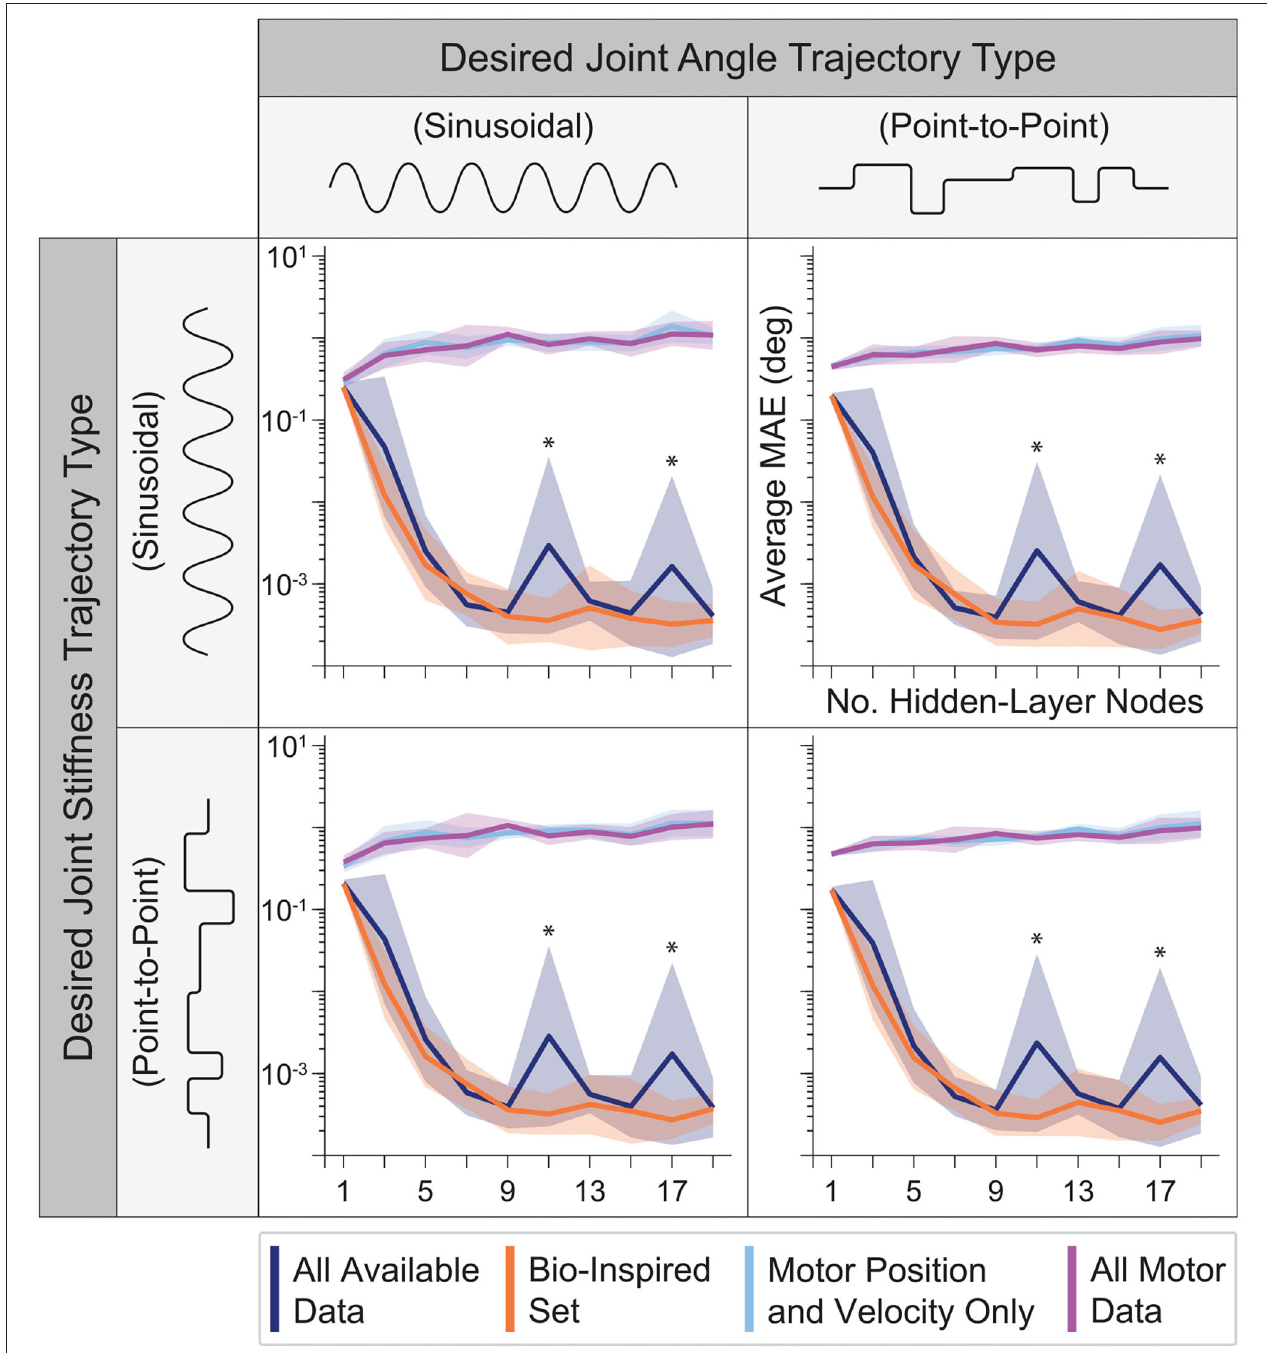
FIGURE 8 | The average performance (MAE) and relative standard deviation ( shaded region ) for each sensory set ( N = 10 ANNs, 15 s of motor babbling) plotted against the number of hidden-layer nodes used by each ANN for all four generalization movements. For any choice in the number of hidden-layer nodes, the ANNs with tendon tension outperformed those trained only with motor information. However, for fewer and fewer hidden-layer nodes, the performance of the ANNs trained without tendon tension improved while the performance of ANNs trained with tendon tension data degraded but always performed best. It can be seen that the performance of the ANNs trained with tendon tension data begin to plateau for 9+ hidden-layer nodes. *Note that because this plotted on a log scale, the peaks for All Available Data at 11 and 17 nodes are on the order of 10 − 3 to 10 − 2 , and therefore do not reflect large variations from the average values but more likely noise.